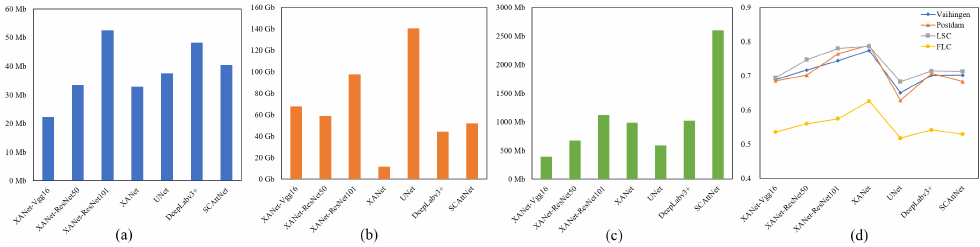
Figure 9. Comprehensive comparison of different segmentation models: ( a ) Params , ( b ) FLOPs ; ( c ) Memory ; ( d ) mIoU